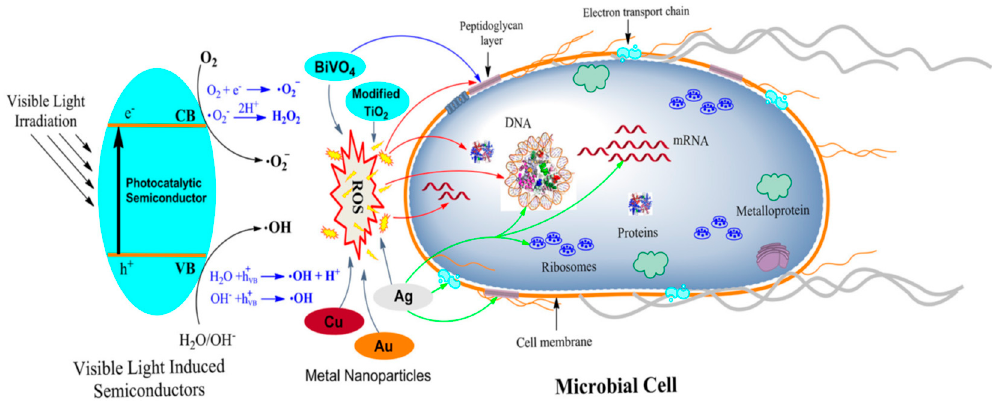
Figure 1. The possible mechanisms of antibacterial activities exhibited by different metal nanoparticles (NPs) and photocatalytic semiconductors. The activation of the photocatalytic semiconductor by visible light is depicted on the left-hand side of the figure. Reactive oxygen species created by various semiconductors destruct bacterial cell components, as indicated by red arrows. Ag, Cu, and Au nanoparticles also generate reactive oxygen species (ROS) for bacterial killing. The green arrow represents targets of Ag. Reproduced with permission from [22]. Copyright Frontiers, 2018.